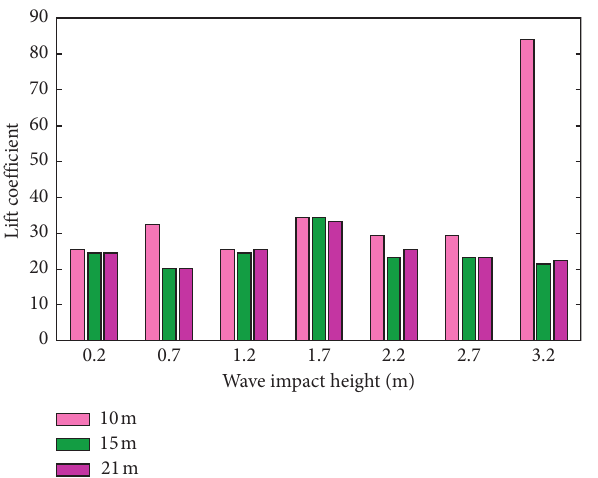
Figure 5: 50 lifting coefficient and resistance coefficient of different water depths in case of working conditions.